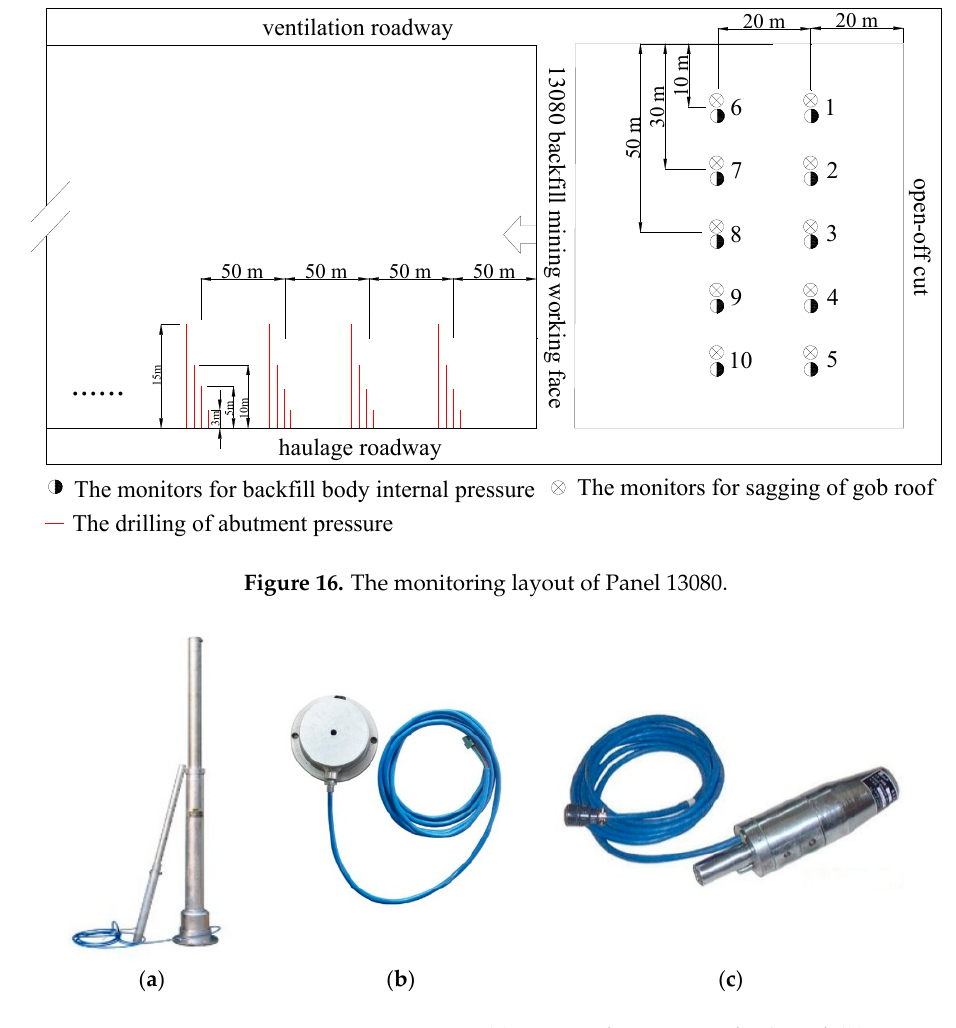
Figure 17. Mine pressure monitoring instruments. ( a ) Monitor for sagging of gob roof; ( b ) Monitor for backfill body internal pressure; ( c ) Borehole stress meter. Table 2. Selection of mine pressure monitoring instruments.